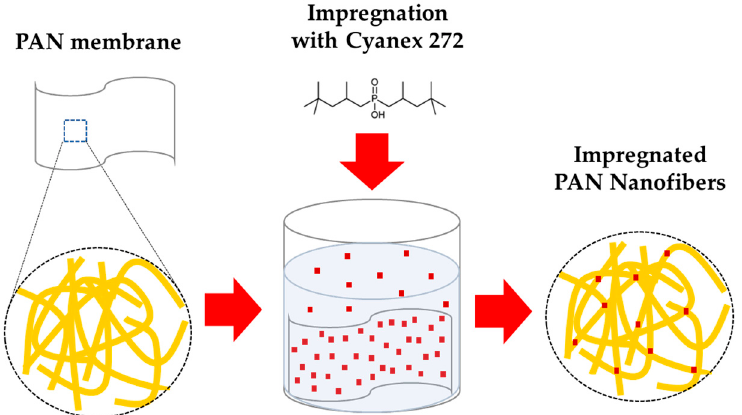
Figure 5. Schematic representation of the impregnation process on PAN nanofiber membrane. Red squares represent Cyanex-272 and yellow fiber represent the PAN membranes.